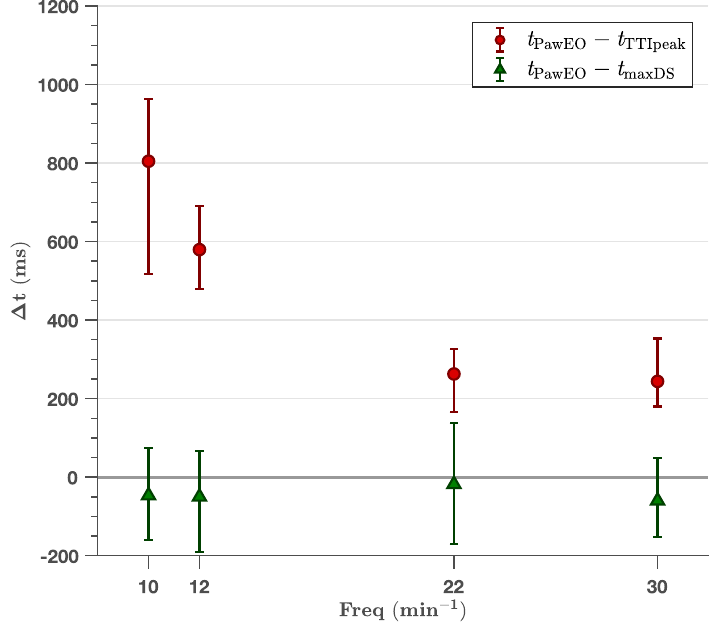
Figure 4. Effect of ventilation frequency in the time differences between the TTI fiducial points (TTI peak, t TTIpeak , and maximum downslope, t maxDS ) and the peak pressure time in the Paw line marking exhalation onset ( t PawEO ). All ventilator settings had a constant tidal volume of 400 mL. The time difference for TTI peak decreased as frequency increased, although not linearly. There was no relation with a median time difference for maximum downslope ( R 2 <